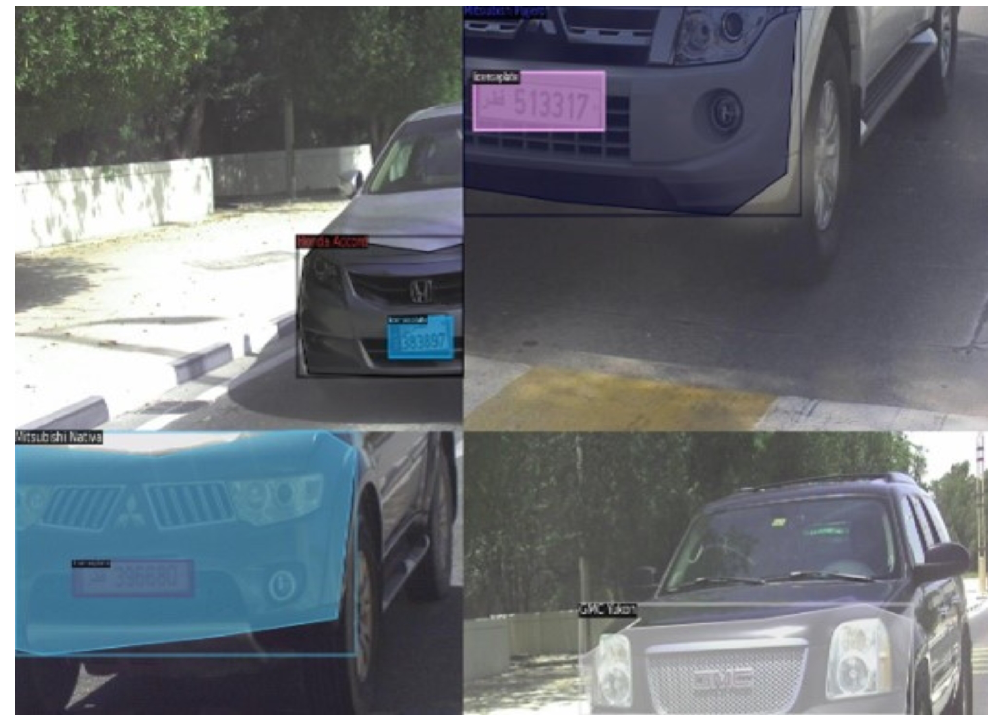
Figure 5. Mosaic-tiled